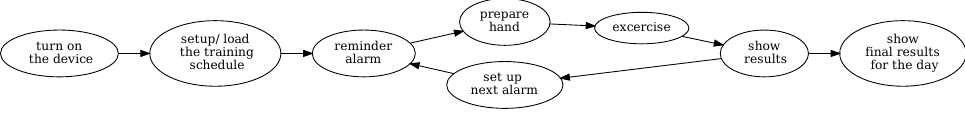
Figure 11. Flowchart of interaction between the patient and the